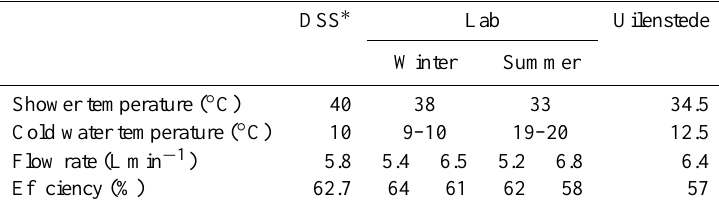
Table 5. Comparison of energy efficiencies.